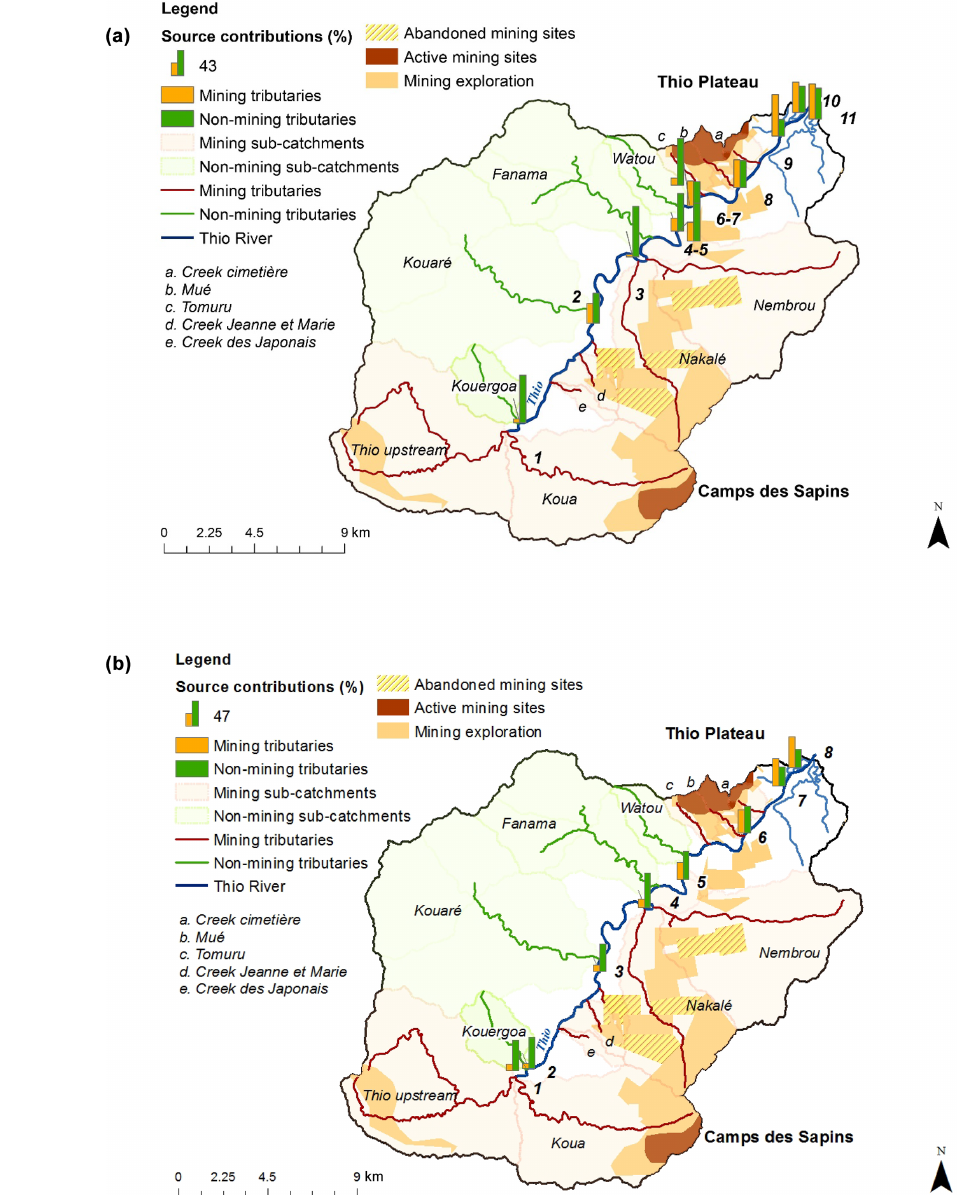
Figure 10. Relative contributions of mining and non-mining tributaries to the sediment collected in the Thio River during the 2015 (a) and 2017 (b) flood events using the FDVS-PLSR